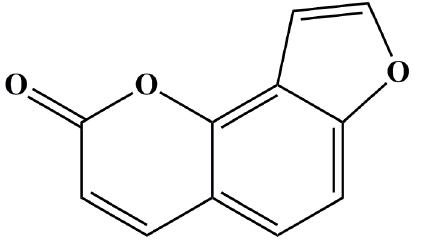
Figure 1. The structure of isopsoralen (IPRN).